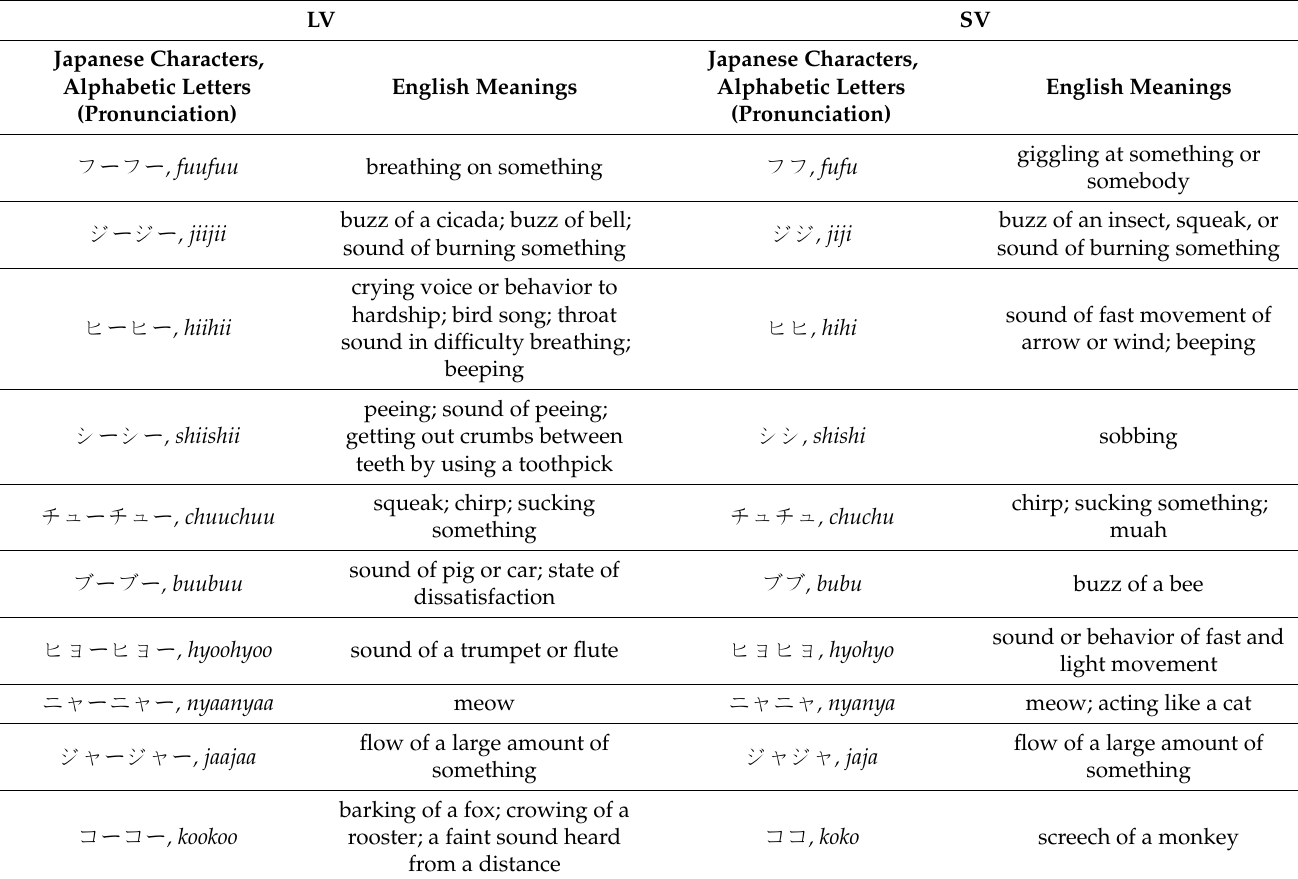
Table A1. Stimuli of Written Japanese Sound-Symbolic Words including Long Vowels (LV) and Short Vowels (SV). LV